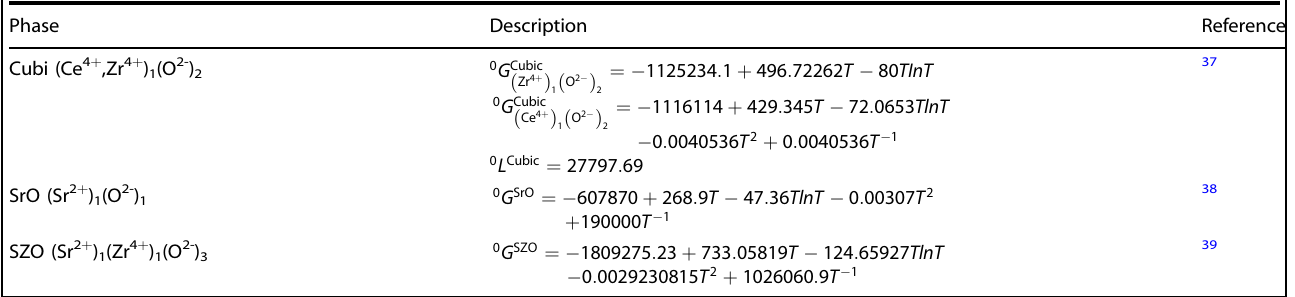
Table 1. Thermodynamic description of the ZrO 2 – CeO 2 – SrO system adopted in this work. Phase